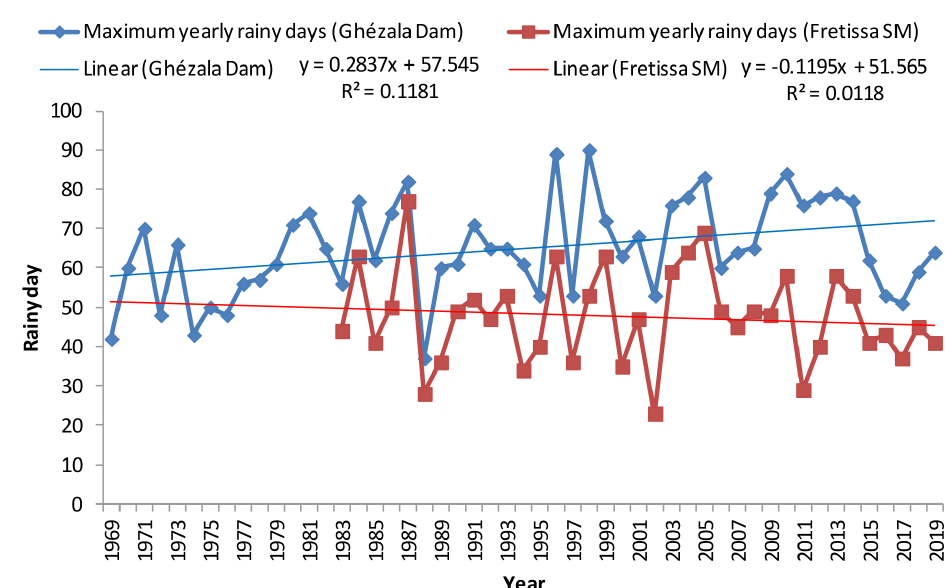
Figure 4. Maximum yearly rainy days for Ghézala Dam and Fretissa SM rain gauges.